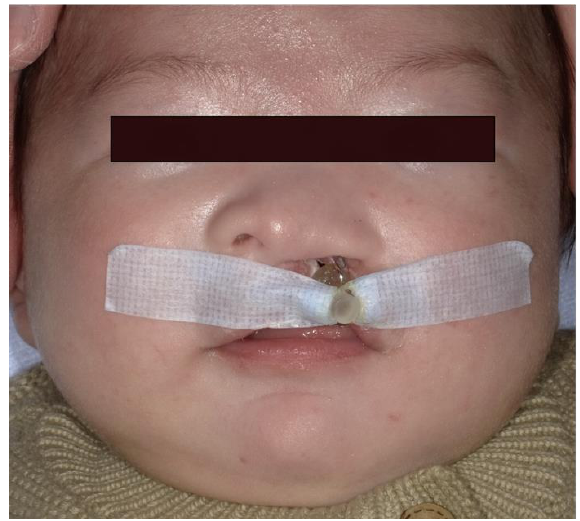
Figure 4. Attachment of the molding